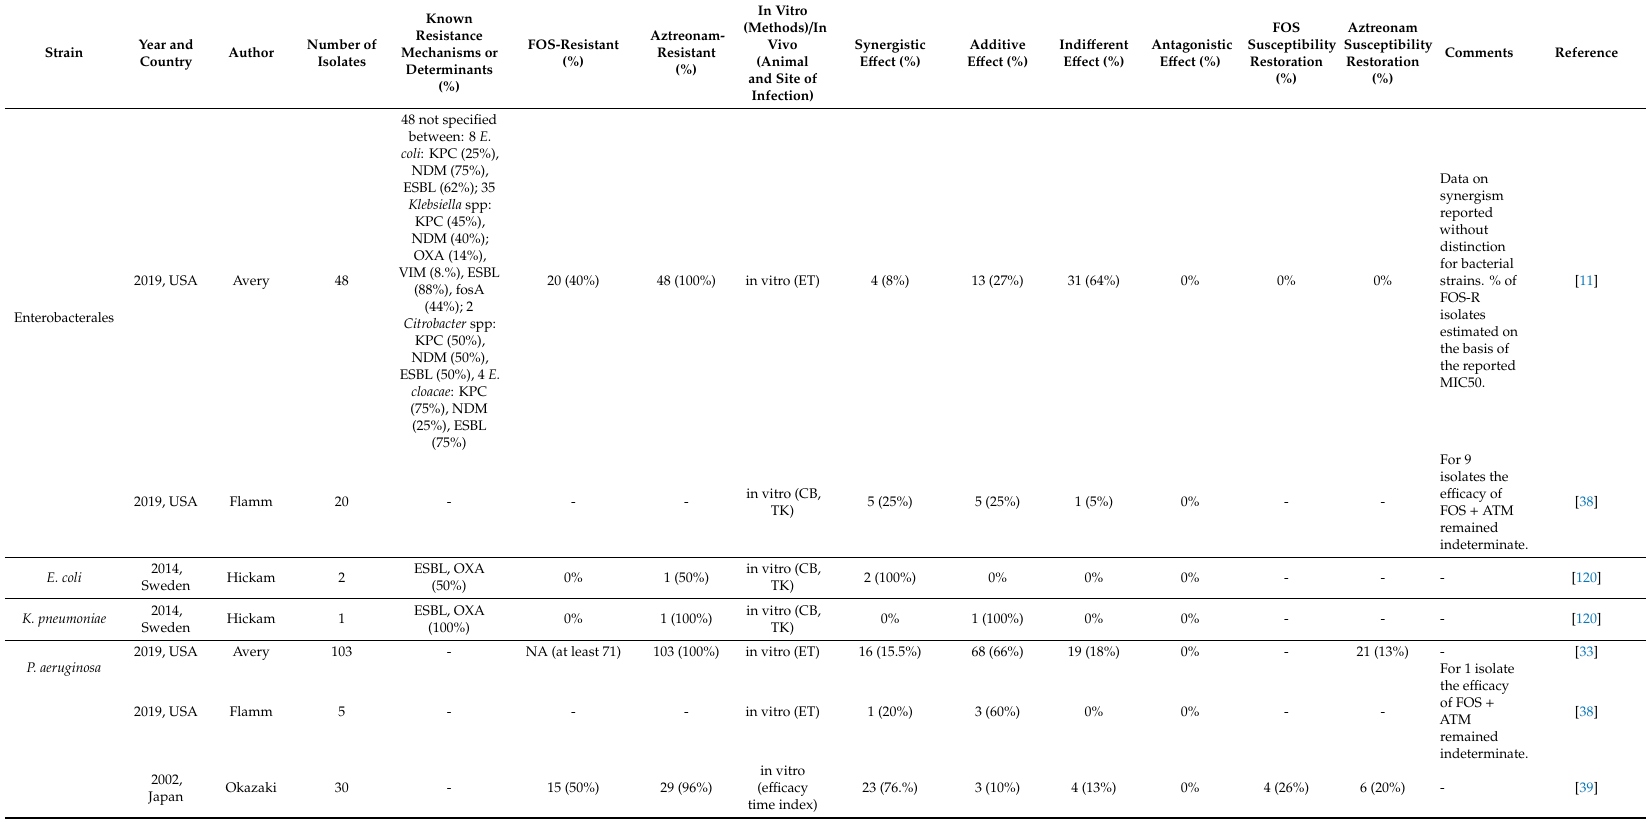
Table 4. Studies on combination between fosfomycin and aztreonam. CB: checkerboard assay; TK: time–kill assay; ET: